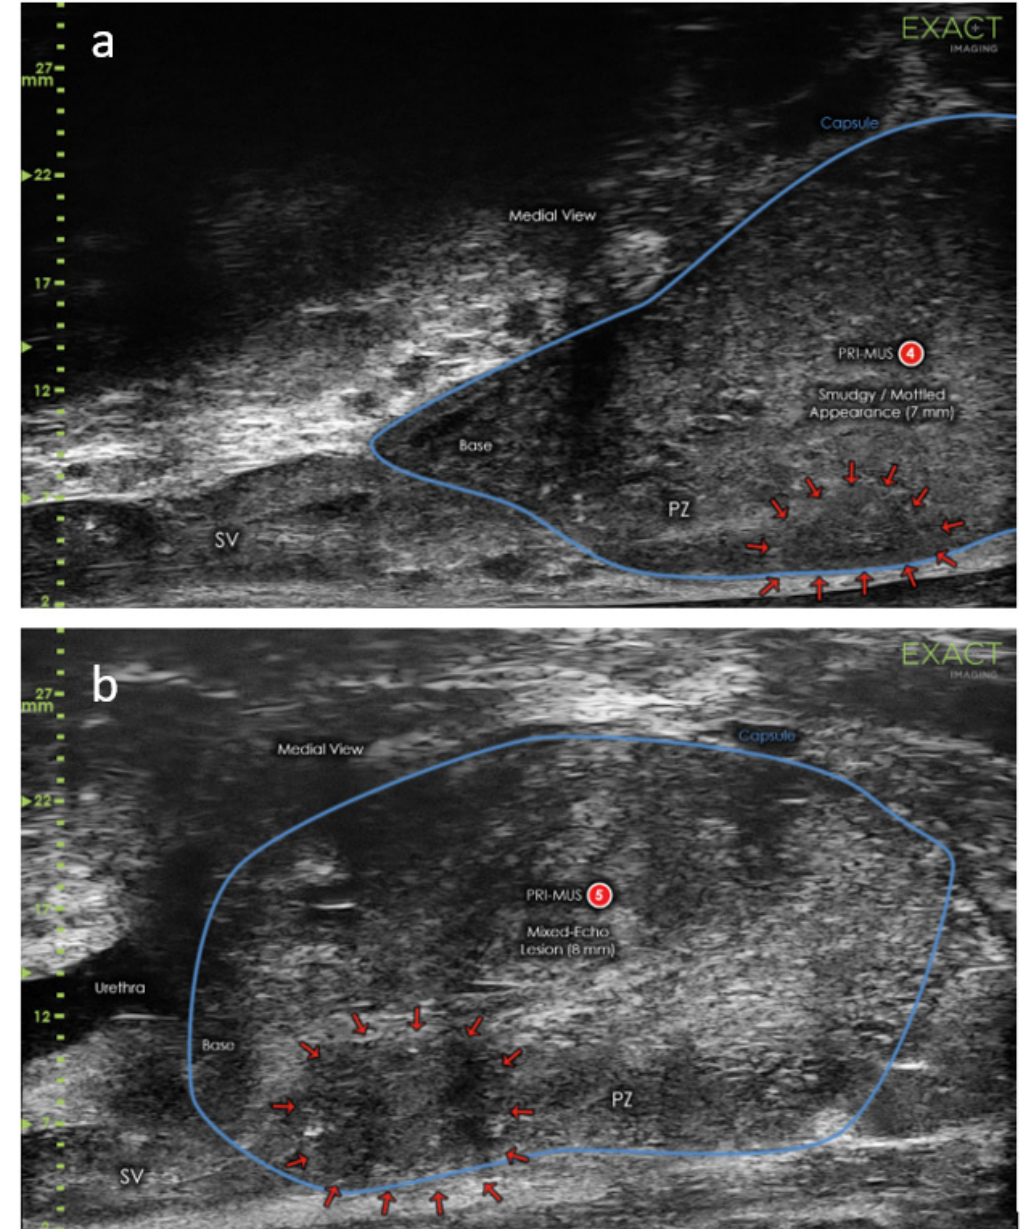
Figure 3. MicroUS images: ( a ) prostate with a PRI-MUS 4 grade lesion (arrows) and ( b ) prostate with PRI-MUS 5 grade lesion (arrows). Images provided courtesy of Exact Imaging.